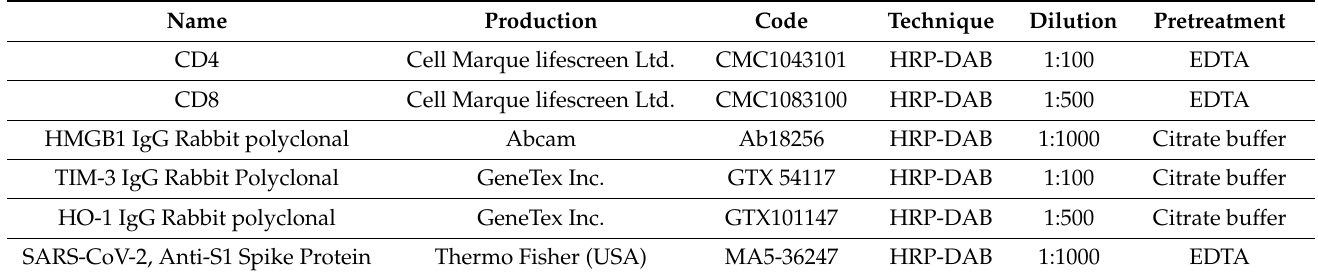
Figure 2. Table and graph relating to the density of CD4+ lymphocytes in the samples of the two groups. Note that there was no statistically significant difference ( p value 0.3380). ns notes not significant.